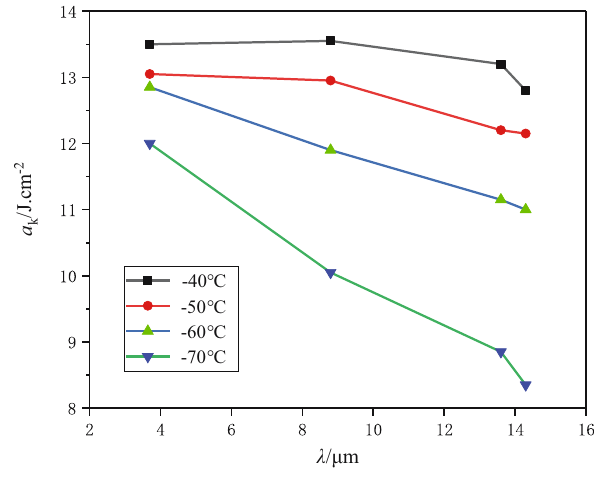
Figure 6: Variation of impact energy with temperature and micro - shrinkage